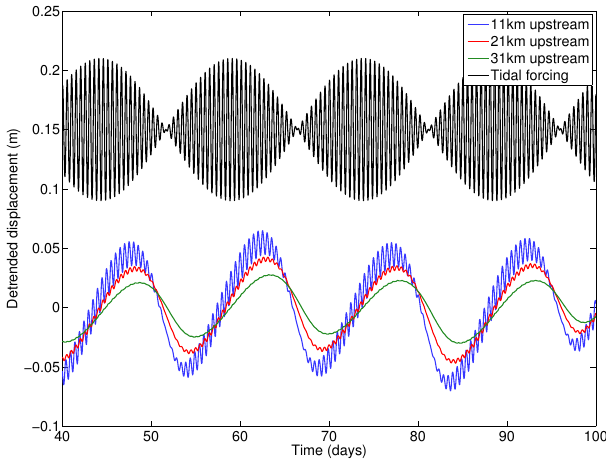
Figure 2. Detrended in-line displacements at 11, 21 and 31km up- stream of the grounding line for the 3-D model run using an ide- alised ice stream geometry. The tidal forcing is also shown, scaled down by a factor of 100 and shifted